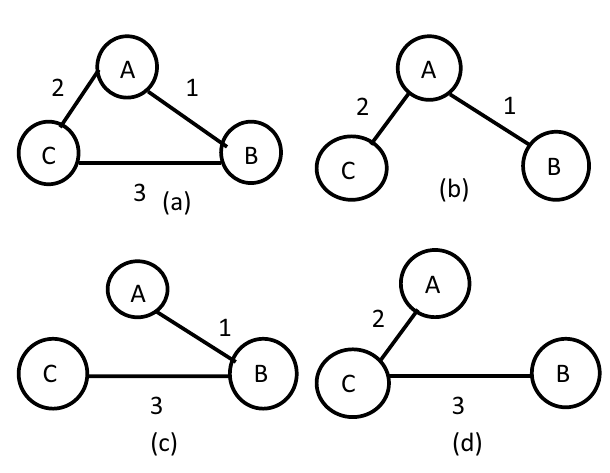
Fig. 4 A Network and its Spanning